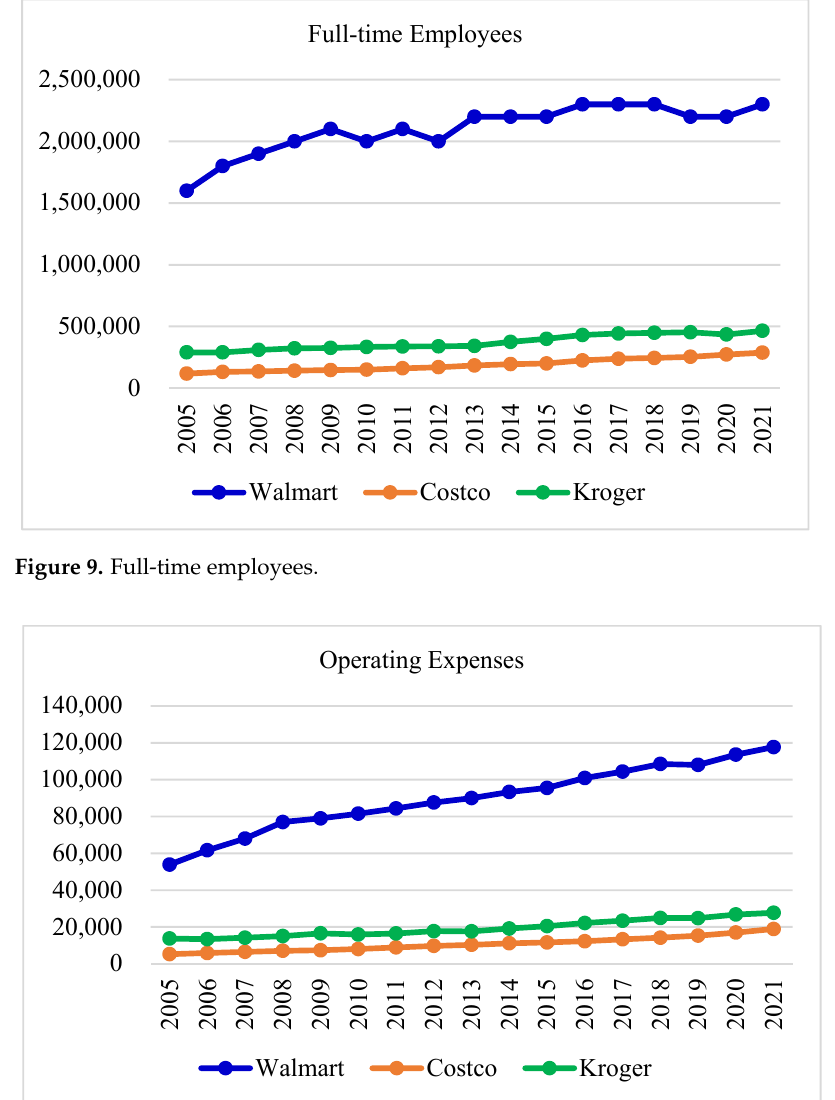
Table 9. Operational efficiencies for top three US retailers.